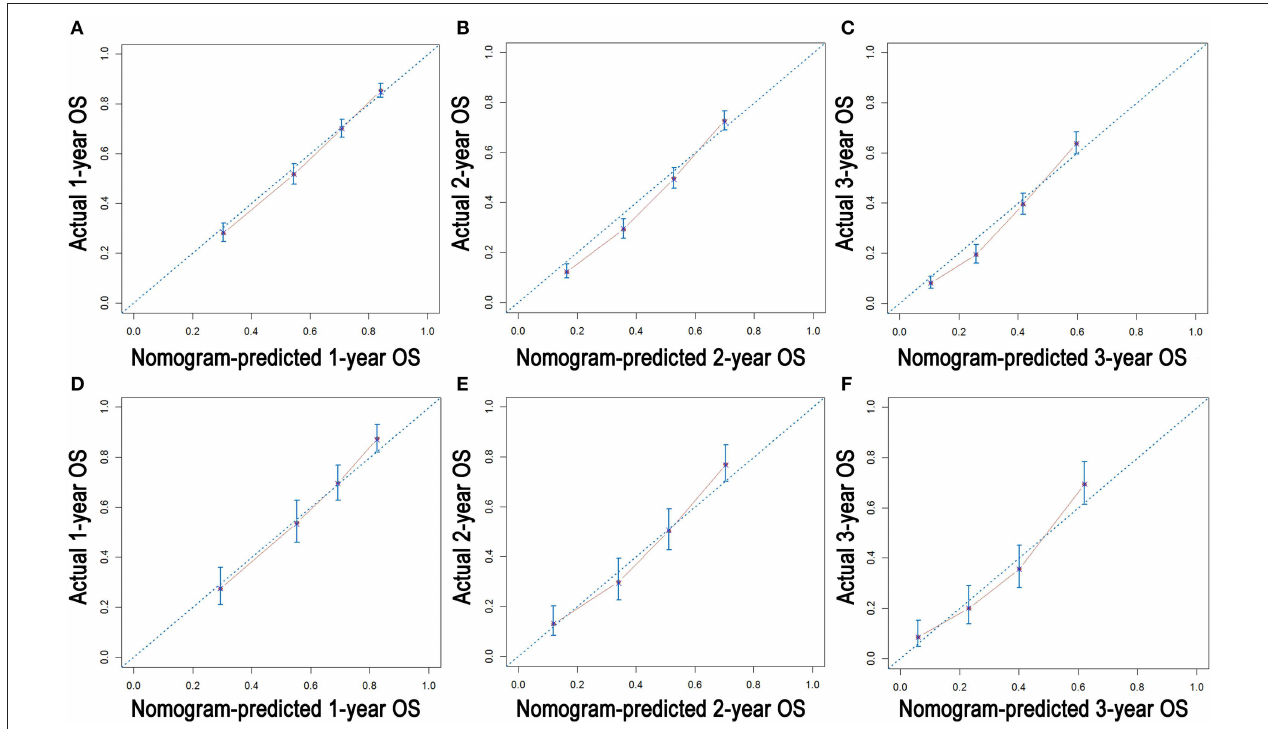
FIGURE 4 | Calibration plots of the nomogram for 1-, 2-, and 3-year OS prediction of the training cohort (A–C) and internal validation cohort (D–F) .